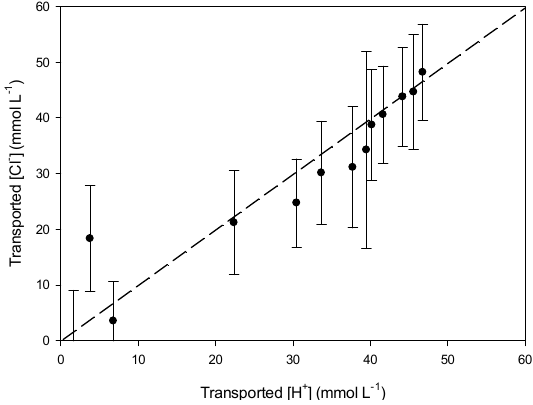
Figure 8. Comparison of the transported [H + ] and [Cl − ] in the feed phase using PIM-8. To confirm this hypothesis, the relation between K + and H + (Figure 9) and Cl − and NO 3 − (Figure 10) was determined as well and a parity plot was used as reference (dashed line). The slopes of both regression curves are above 1 (a = 1.24) meaning that there is no coupled relation (co-transport) between the corresponding cations and anions. Consequently, co-transport seems to be the main transport mechanism in our system.